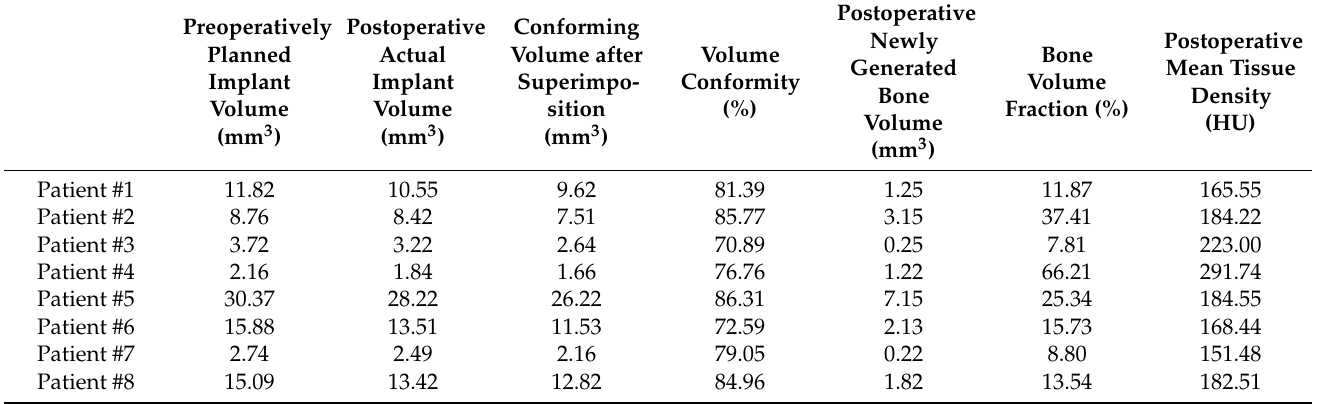
Table 3. Volume and density